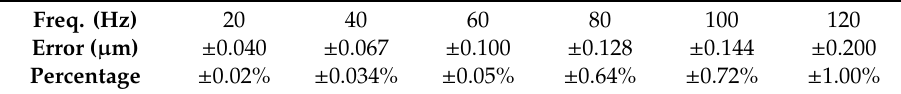
Figure 10. The control performance, ( a ) tracking response for 20 Hz harmonic trajectory, ( b ) tracking error for 20 Hz and 40 Hz trajectory, ( c ) tracking error for 60 Hz and 80 Hz trajectory, and ( d ) tracking error for 100 Hz and 120 Hz trajectory. Table 5. Summarized tracking error in terms of different frequencies.